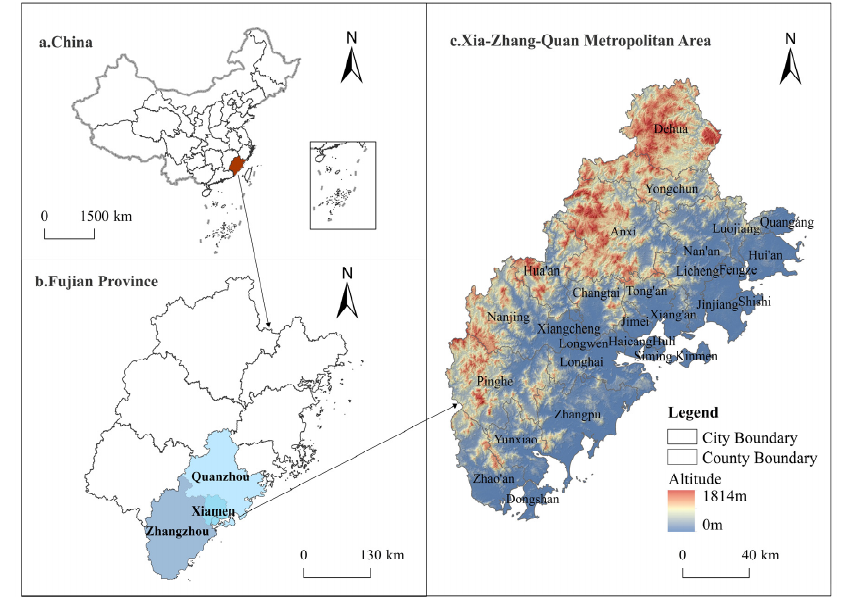
Figure 1. Geographical location and elevation of study